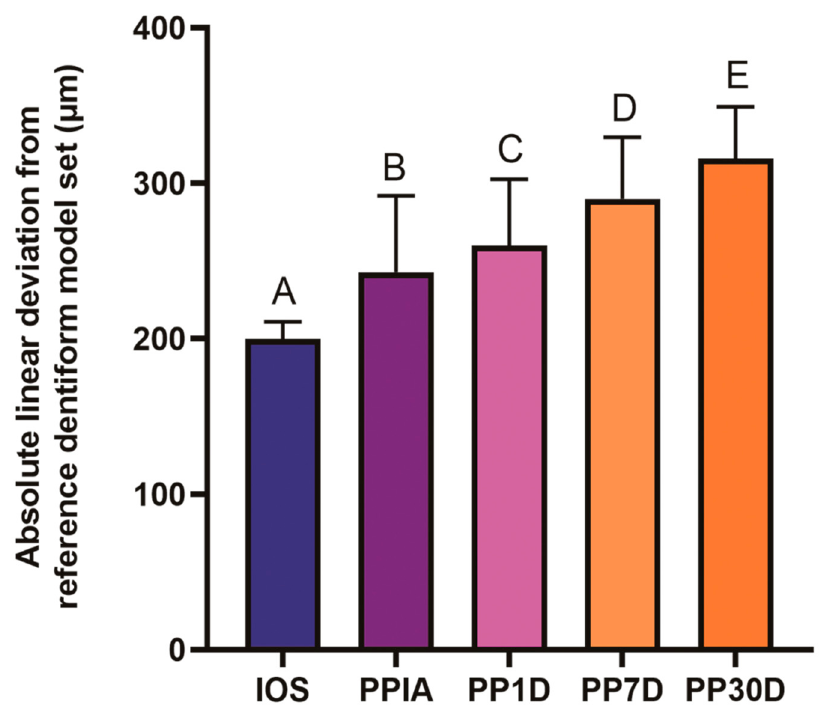
Figure 4. Linear deviation values of all groups. Data expressed as mean ± standard deviations. Dif- ferences among groups with p < 0.05 expressed in different capital letters.